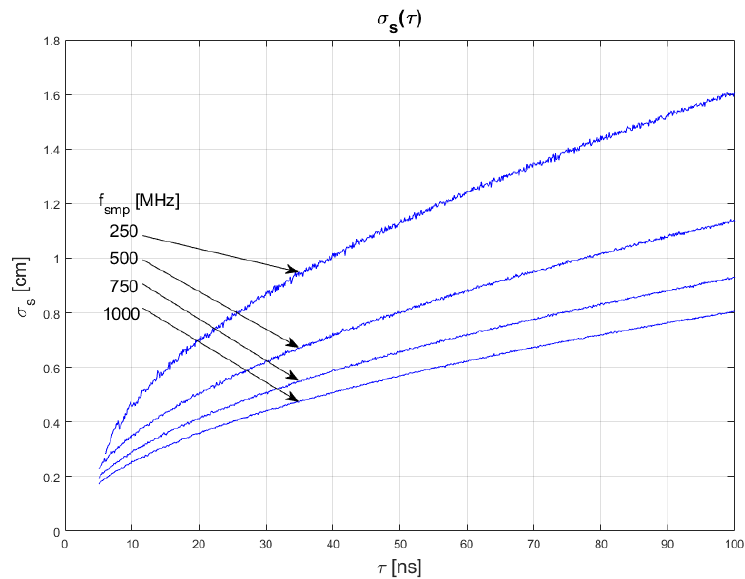
Figure 8. Dependence of measurement uncertainty on pulse width for τ for SNR = 100. Parameters of generated pulses are shown in Table 3 Block 5.